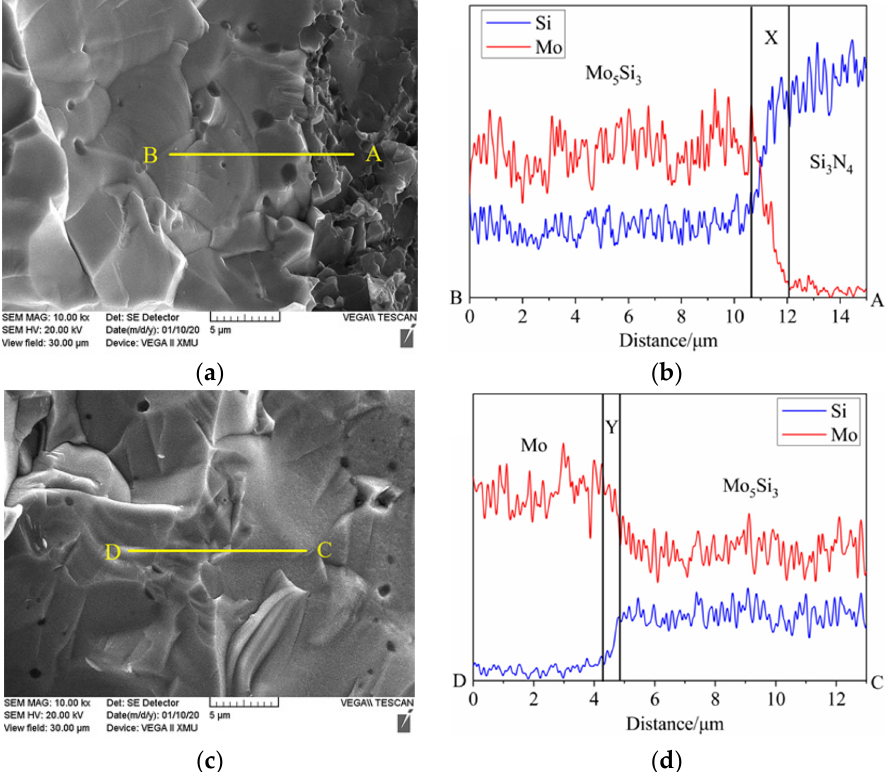
Figure 6. Enlarged morphologies of the interface area near ceramic matrix ( a ) and the corresponding EDS line scan result ( b ); enlarged morphology of the interface area near metal layer ( c ) and the corresponding EDS line scan result ( d ) for 9SM composite.